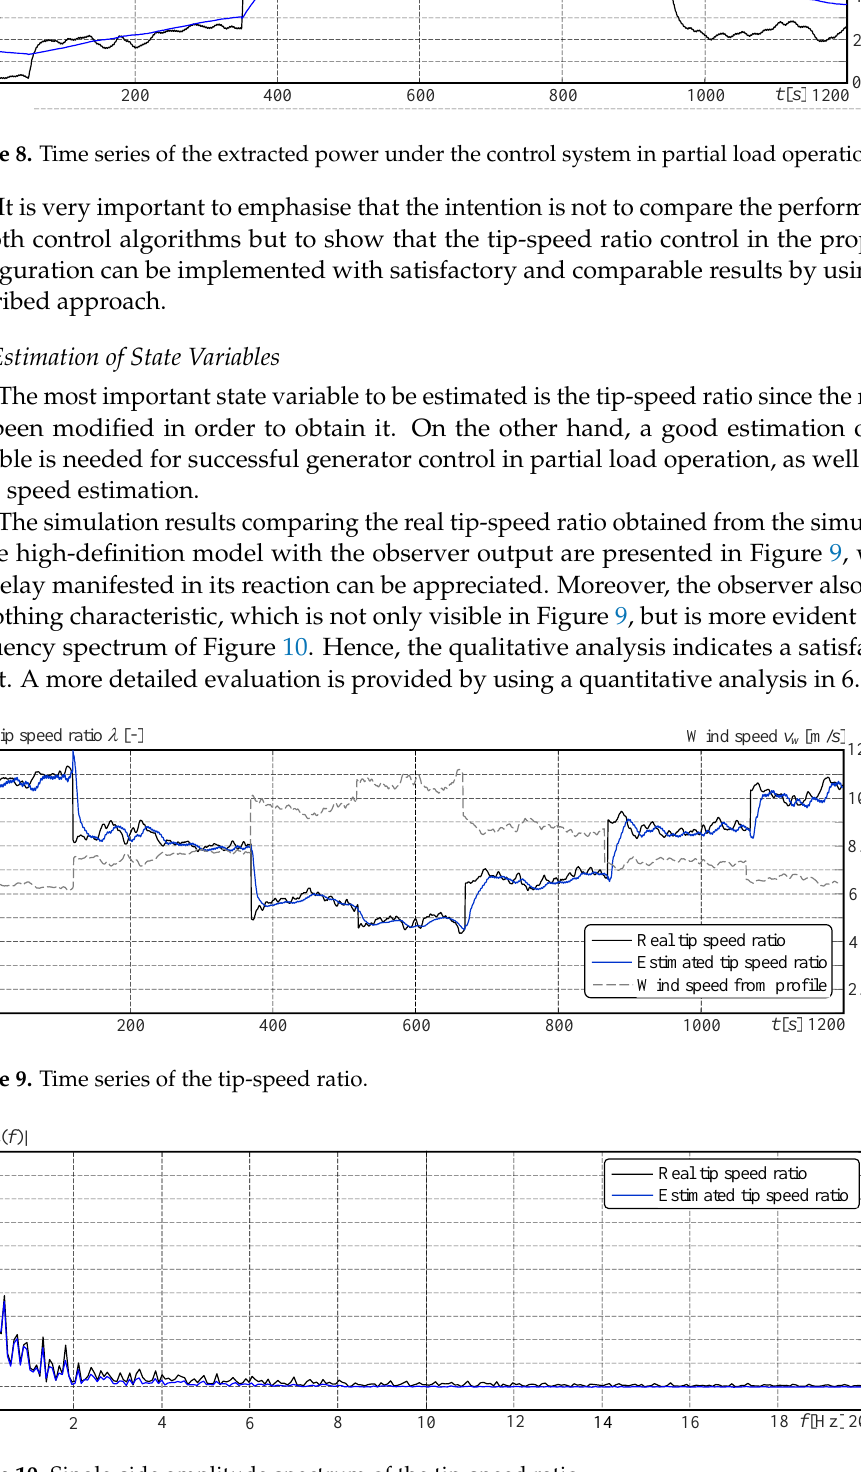
Figure 11. Relationship between λ and μ .